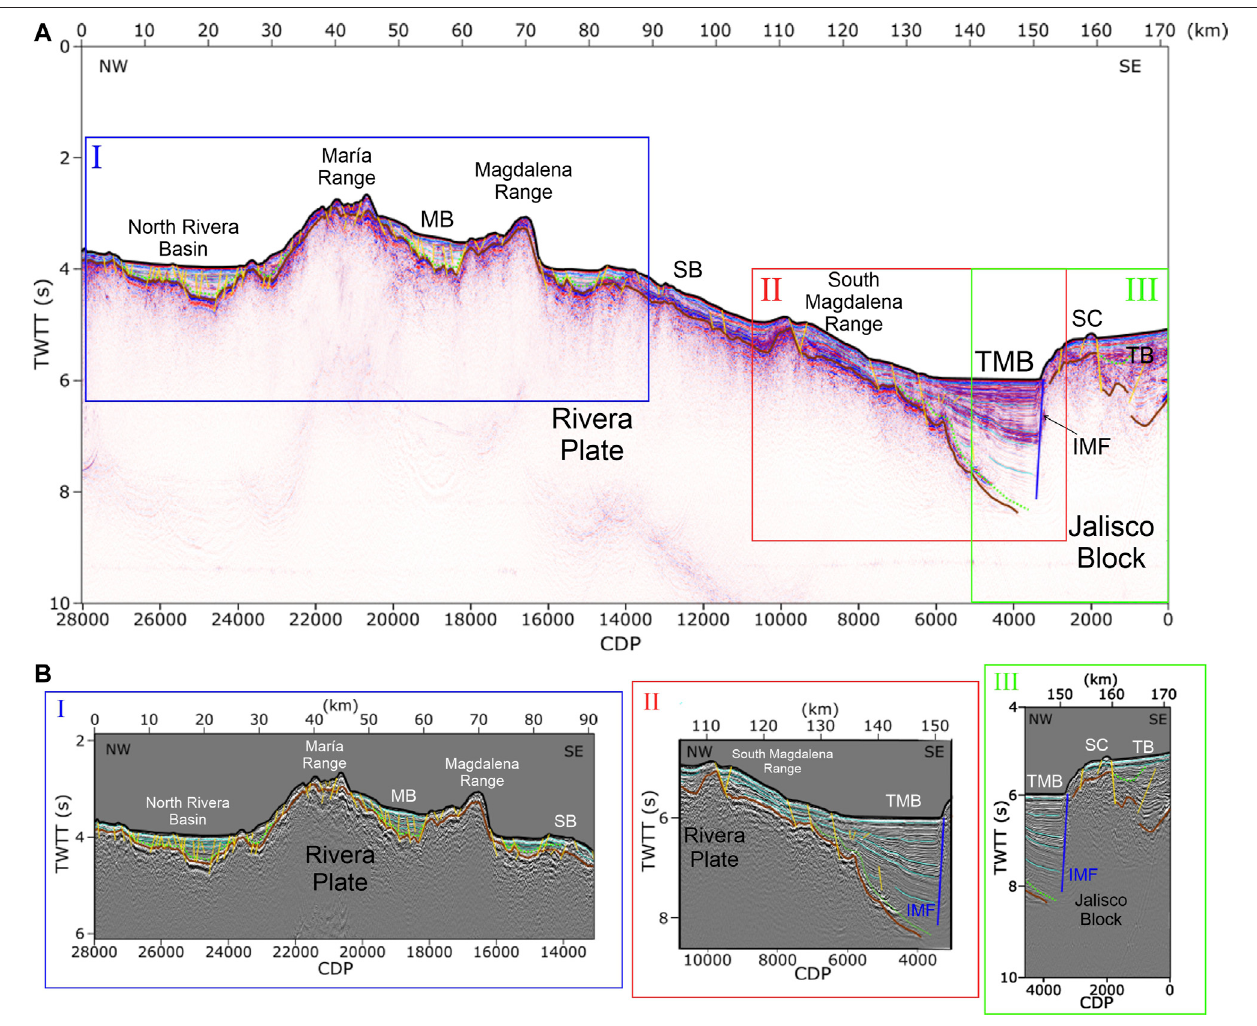
FIGURE 6 | TS08 Multichannel Seismic Pro fi le. (A) Migrated seismic line with Zones I, II, and III indicated for a better interpretation. (B) Enlargements of Zones I, II, and III. Abbreviations : CDP , Common Depth Point; IMF , Islas Marías fault; MB , Magdalena basin; SB , Sisvoc basin; SC , Sierra de Cleofas; TB , TsuJal basin; TMB , Tres Marías basin; TWTT , two-way travel